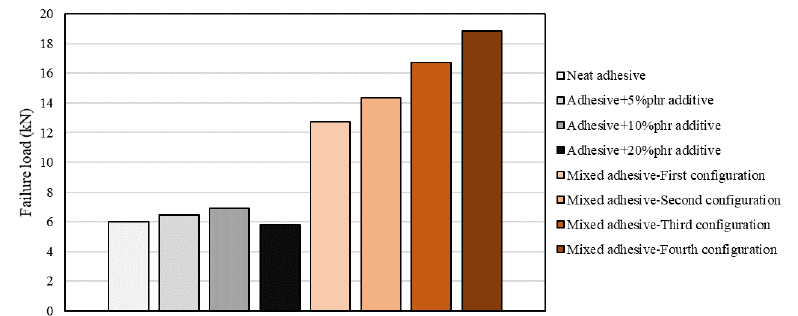
Figure 13. Effect of mixed and functionally graded adhesive layer. Adapted from [105].